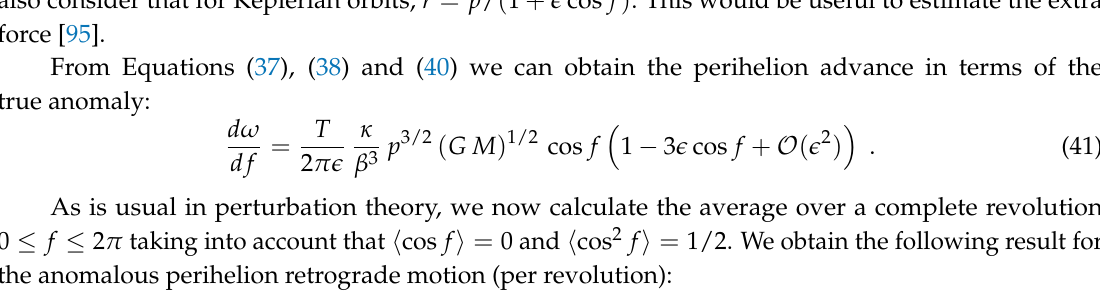
(cid:112) 1 + y 2 —is also